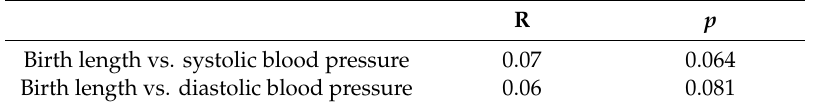
Table 3. Correlation analysis between blood pressure values and body length of newborns.